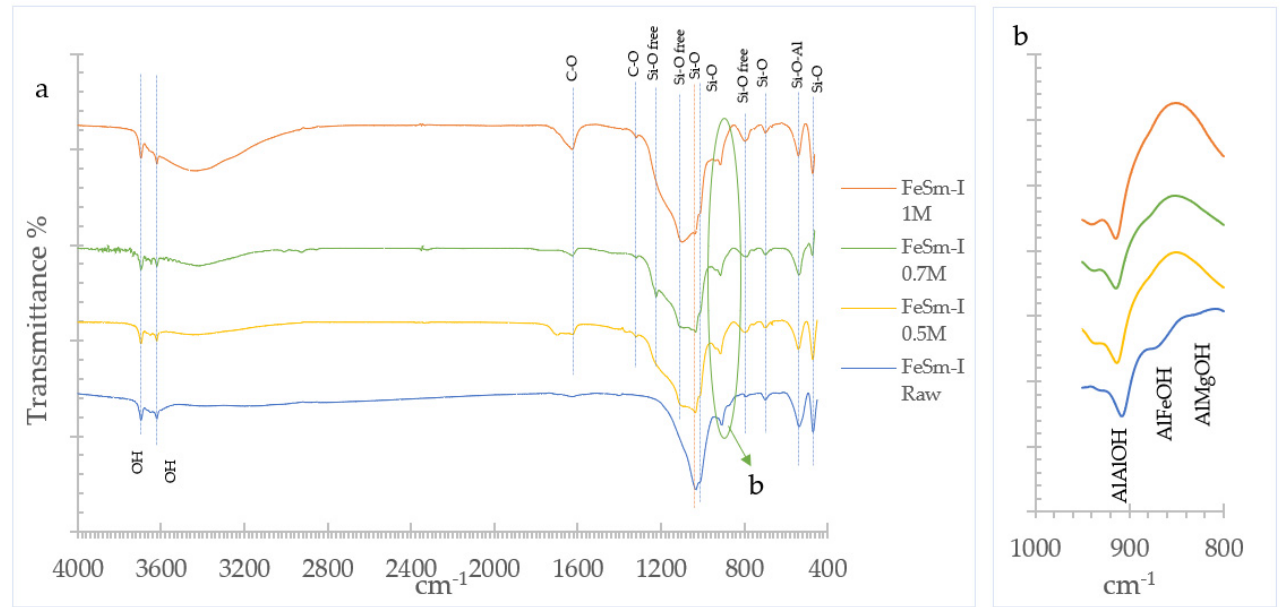
Figure 4. ( a ) FTIR spectra of FeSm-I smectite (raw and activated with 0.5, 0.7, and 1 M oxalic acid); ( b ) FTIR spectra (section 1000 − 800 cm − 1 ) of raw and treated FeSm-I smectite.